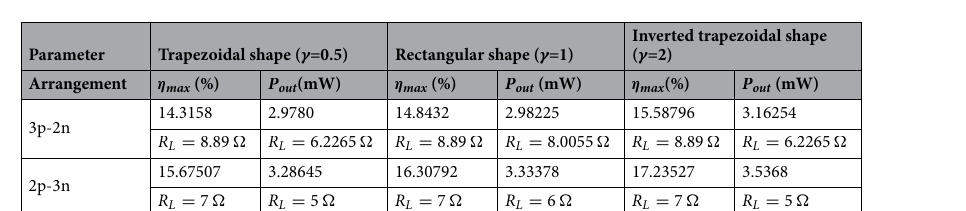
Inverted trapezoidal shape ( γ =2)